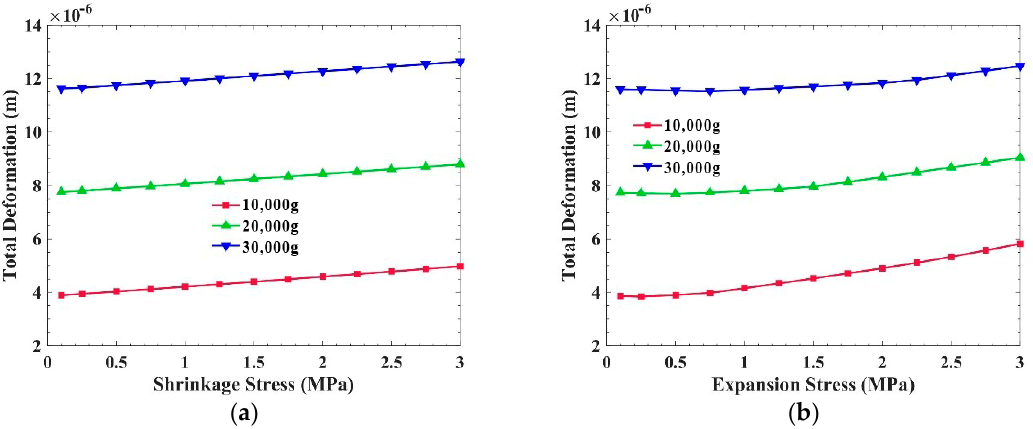
Figure 10. Influence of the different internal stresses of the potting adhesive on the total deformation of the PCB which is parallel to the overload direction: ( a ) Shrinkage stress; ( b ) Expansion stress.